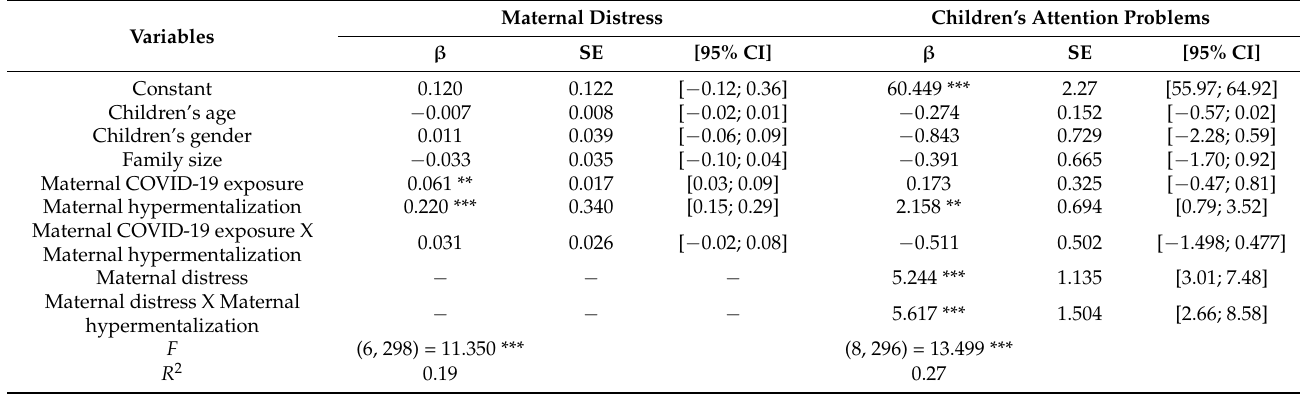
Table 3. Moderated Mediation Model—Model 2.